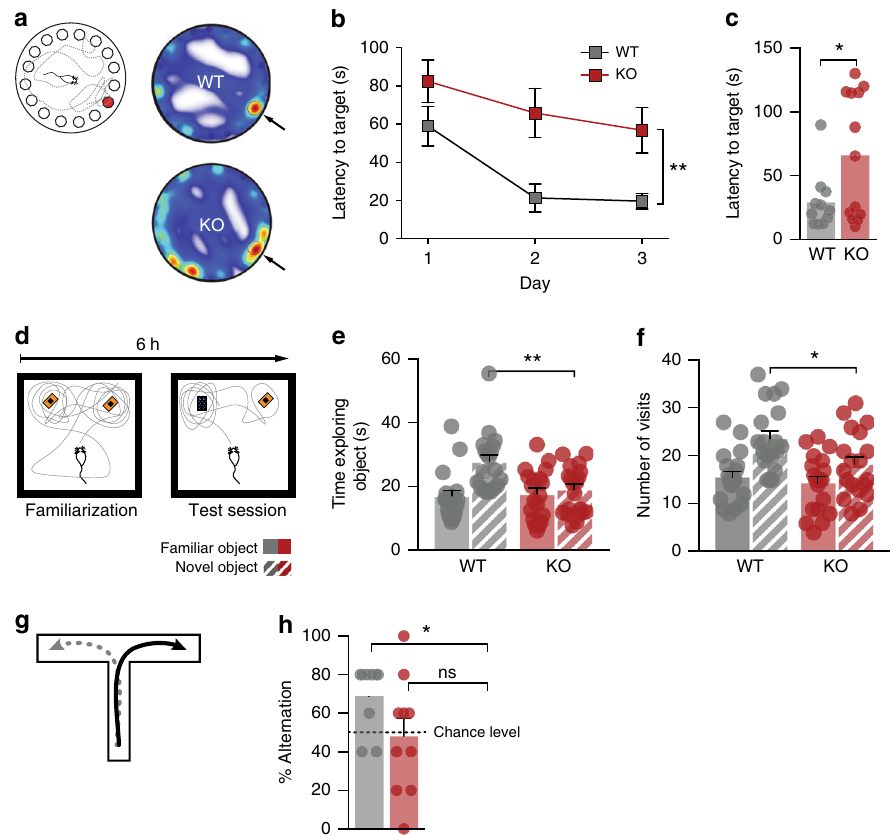
Fig. 7 Memory and learning impairments in Gprasp2 − /y mice. a Schematic diagram of a Barnes Maze test (left) and representative heat map analysis from probe trials of Gprasp2 − /y mice and WT littermate controls (right). b , c Gprasp2 − /y mice display increased latency to reach target hole during training sessions ( b ) and increased latency to reach target region on the probe day ( c ); WT n = 11, KO n = 13; repeated measures two-way ANOVA for ( b ) and two- tailed t -test for ( c ). d Schematic diagram of the novel object recognition task. e , f Reduced time ( e ) and number of exploratory ( f ) visits on a novel object test by Gprasp2 − /y mice ; WT n = 19, KO n = 19; two-tailed t -test for ( e ) and two-tailed Mann – Whitney test for ( f ). g Schematic diagram of